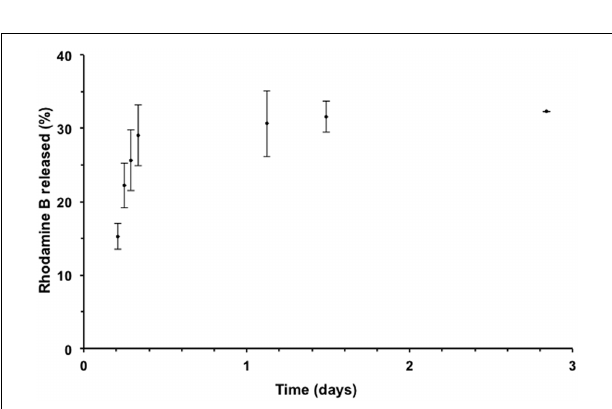
FIGURE 1 | Scanning electron micrograph of RhB-loaded PLGA NPs.